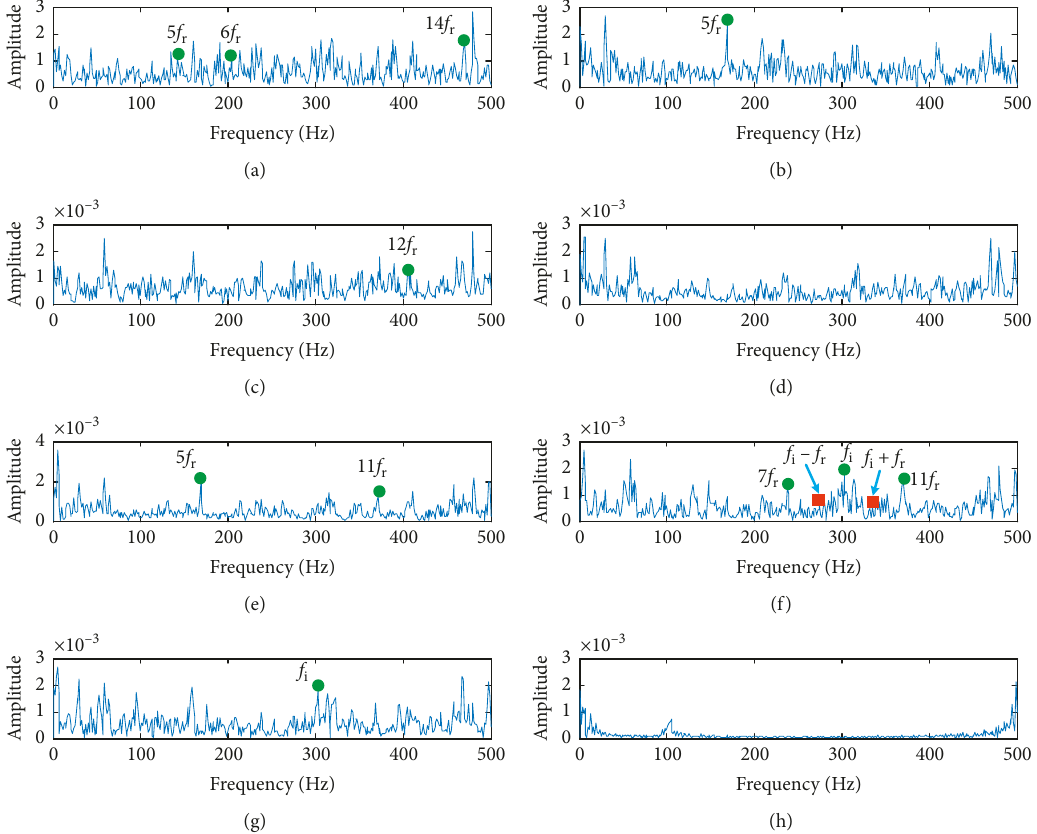
Figure 21: The Frequency domain diagram of multiresolution DMD modes of the inner race fault signal, where (a)–(h) are corresponding to signals in Figure 18,